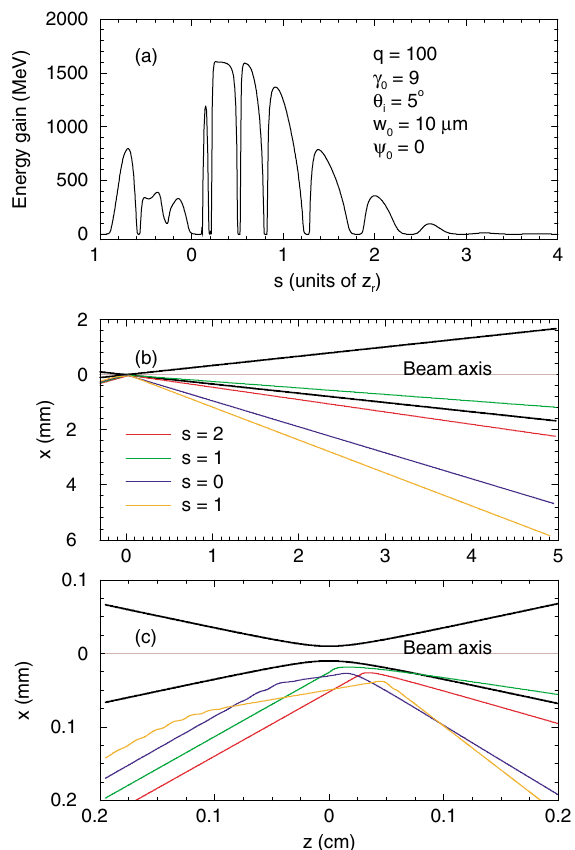
FIG. 7. (Color) For an electron with initial velocity vector (cid:3) (cid:2) 3 mm ) to (0,0, s ) the following ; 0 ; z pointing from ( x 0 0 are shown: (a) variation of the energy gain with s , (b) the actual trajectories of four cases corresponding to different values of s , and (c) a magnified portion of (b) around the laser beam focus. The laser wavelength is (cid:20) (cid:3) 1 : 056 (cid:28) m . Note that, (cid:3) (cid:2)(cid:4) s (cid:2) z (cid:6) tan (cid:6) . See Fig. 1(a). The in this configuration, x i 0 0 interaction time, in all cases, is such that !t (cid:3) (cid:21) (cid:9) 10 5 and terms of the order of 5 in the diffraction angle have been used to model the fields. In (b) and (c) the dark lines mark the beam boundaries . The legends in (b) apply to (c) as